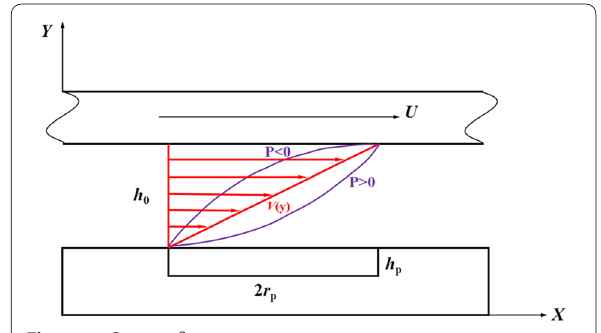
Figure 1 Couette